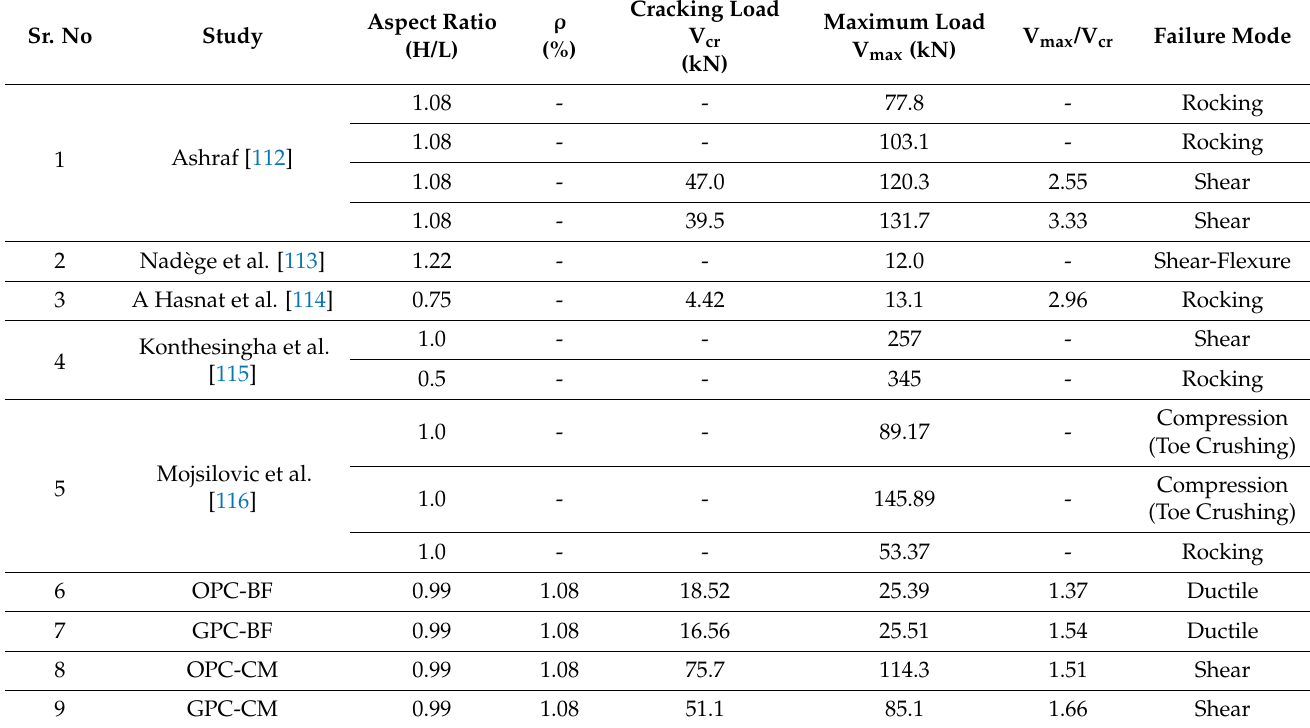
Table 5. Comparison of the present study with past studies on unconfined masonry.